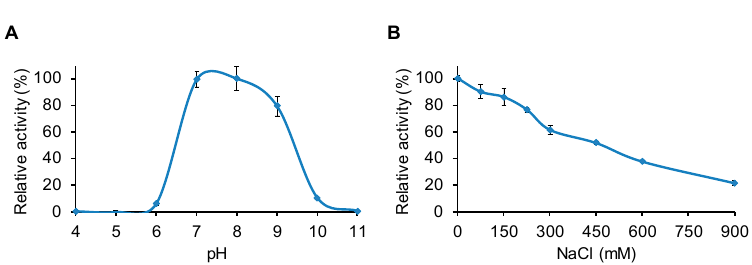
Figure 3. Determination of pH and NaCl optima for LysBC17 by TRA. ( A ) pH range for LysBC17 activity (5 µg/mL) was tested in borate-phosphate buffer versus B. cereus cells. ( B ) Range of NaCl for LysBC17 activity (5 µg/mL) was tested in 50 mM NaH 2 PO 4 , pH 7.0 versus B. cereus cells. N = 3 for all experiments. Relative activity of 100% assigned to the maximum value in the data set. Error bars represent the standard deviation.